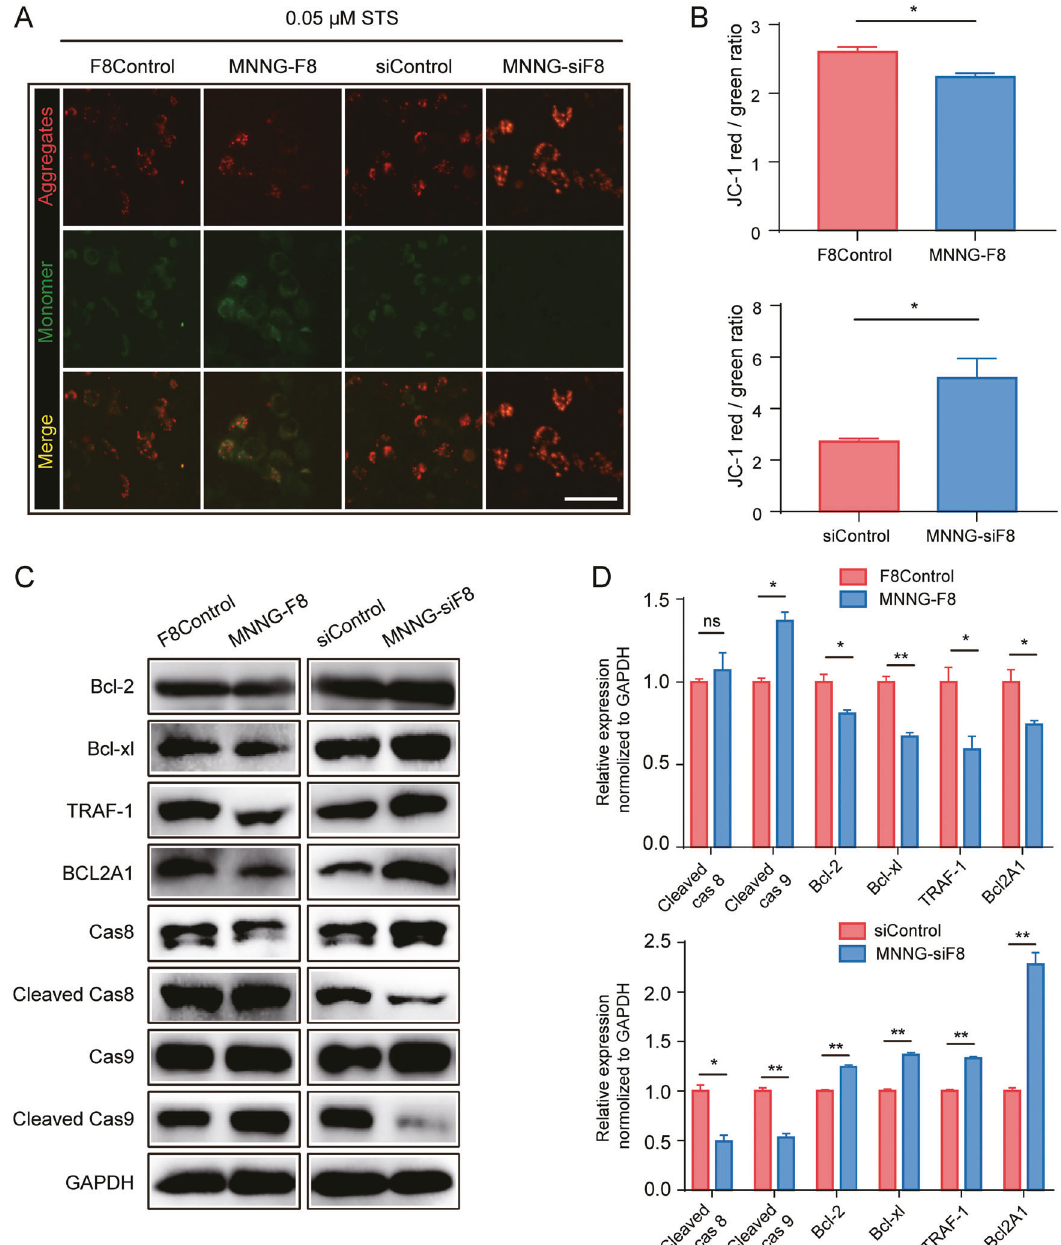
Fig. 5 Apoptosis in FUT8-regulated OS cells occurs through a mitochondria-dependent pathway. A Representative immuno fl uorescent images of JC-1 staining in the four OS cell lines after treatment with 0.05 μ M STS for 24 h. High ratios of red/green fl uorescence represented a high mitochondrial transmembrane potentials ( ΔΨ M) while low ratios of red/green fl uorescence represented a low ΔΨ M (Scale bar: 25 μ m). B Mean ± SD ( N = 3) ratios of JC-1 red/green fl uorescence. C Western blot of mitochondria-dependent apoptosis-related proteins (Bcl-2, Bcl-xl, B fl -1, cleaved-caspase 8, and cleaved-caspase 9) con fi rmed that, compared to control cells, anti-apoptosis proteins were less abundant in MNNG-F8 cells but were more abundant in MNNG-siF8 cells. Relative expression was normalized to GAPDH. D Quantitation of relative expression (mean ± SD, N = 3) of mitochondria-dependent apoptosis-related proteins. ns, På 0.05; * P < 0.05; ** P <